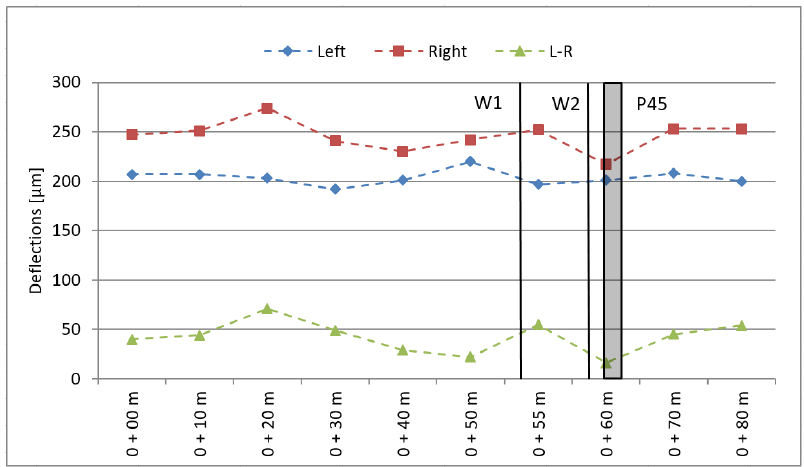
Figure 4. Pavement testing—static deflections (W1, W2—strain gauge load cell sensors; P45—piezoelectric sensors).